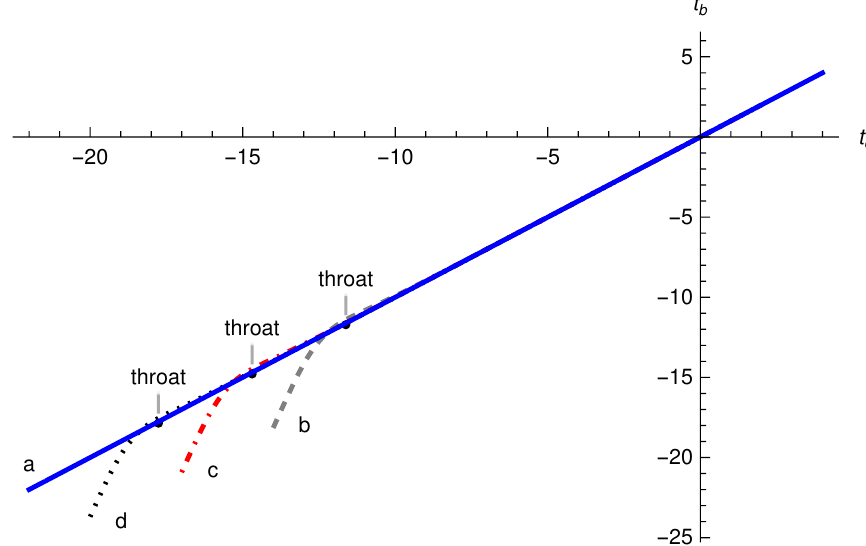
Figure 5. Plots of Equation (114) for various choices as given by Equation